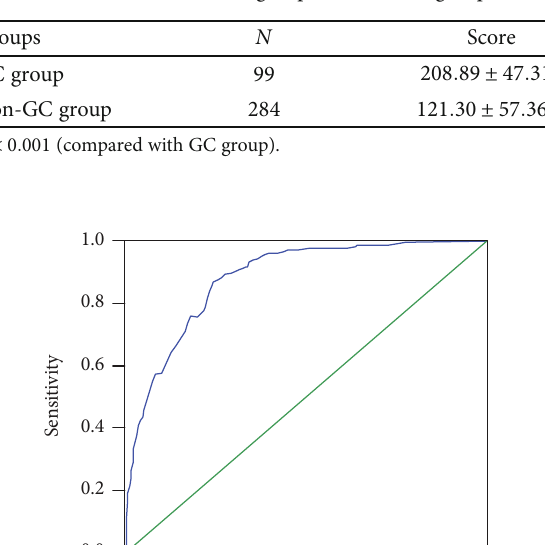
Table 6: Scores of GC group and non-GC group.